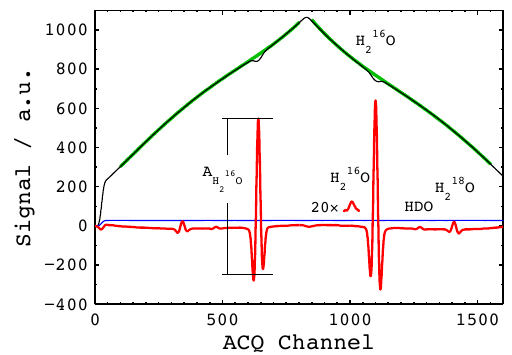
Fig. 1: Optical system of the ISOWAT II spectrometer. LD: laser diode; P-BS: pellicle-beam splitter; MPC: multipass cell; SD: sample detector; RD: reference detector; BD: background detector; MP: miniature pump.